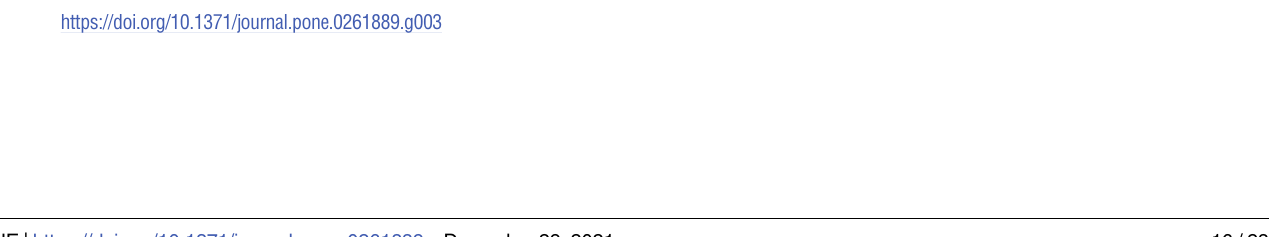
PLOS ONE | https://doi.org/10.1371/journal.pone.0261889 December29,